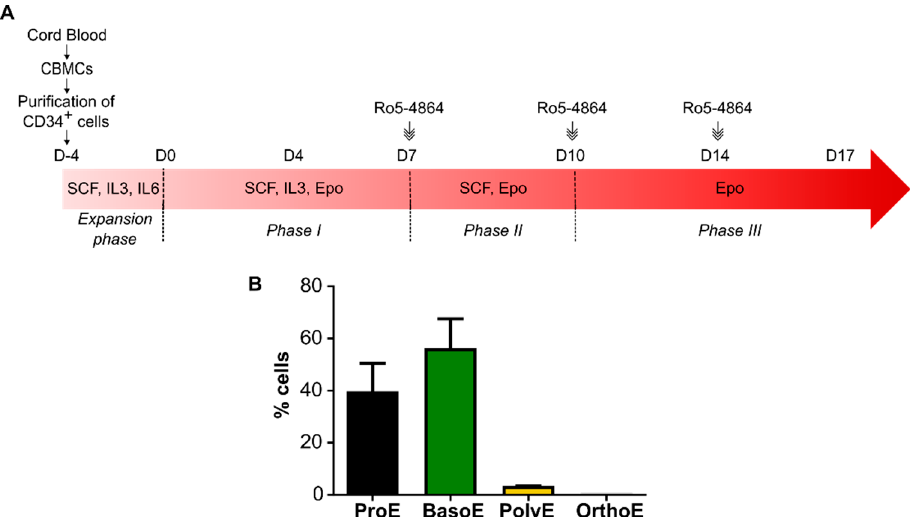
Figure 4. Ex vivo erythropoiesis protocol adding Ro5-4864 at the terminal phase. ( A ) Schematic of the ex vivo erythroid differentiation protocol following Ro5-4864 treatment. Cord blood mononucleated cells (CBMCs) were used to isolate CD34+ progenitors. Fifty micromolar of Ro5-4864 were added starting from Day 7. At Day 10 and 14, when media was changed, Ro5-4864 was added at the same concentration. ( B ) Quantification of the percentage of the different erythroblastic stages (ProE = proerythroblast, BasoE = basophilic erythroblast, PolyE = polychromatic erythroblast, OrthoE = orthochromatic erythroblast) after MGG coloration at Day 7 of differentiation ( n = 3).